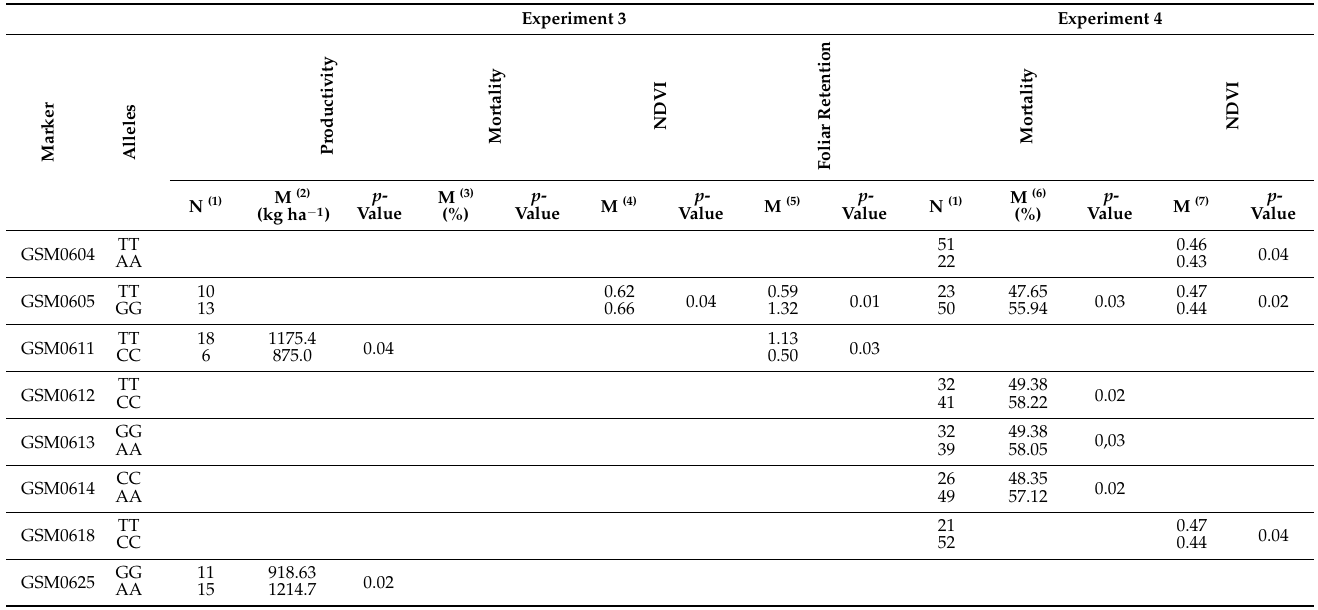
Table 7. Association of SNPs and productivity (kg ha − 1 ), mortality (%), NDVI and leaf retention variables in different Brazilian soybean genotypes under flooded